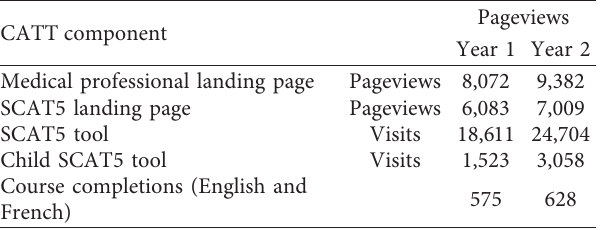
Table 2: The CATT for medical professionals website Google